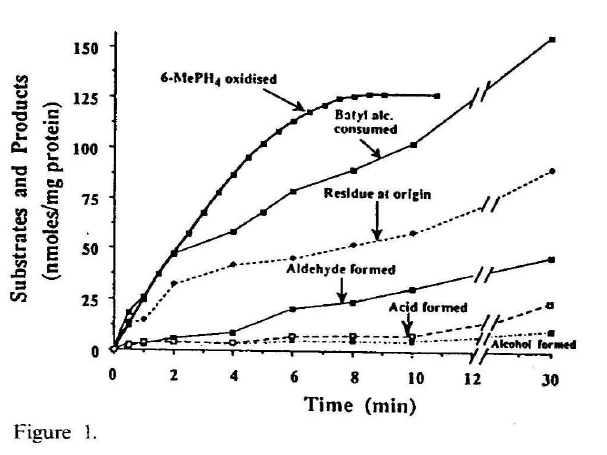
Figure I. the direct assay in Tris-HCl pH 7.5, it would dehyd rate rapidly to the quinonoid species (4). In the pre sent assays the analytical wavelength for studying the rate of change of absorbance was 345 nm, a wavelength at which the 4a-hydroxypterin (5) has no absorbance whatsoever, and the formation of the quinonoid species only was recorded. For the first study of the stoichiometry the experiments were per formed in two parts. In the first part the rate of change of absorbance (at 345 nm) was measured using the direct spectrophotometric assay procedure and the amounts of 6-MePH oxidised at time inter 4 vals were evaluated. In the second part of the exper iment a mixture containing the same ingredients as for the direct spectrophotometric method (see ra diolabel method in MaterialS and Methods): but scal.ed up to 14 ml and using 14C-batyl alcohol, was similarly initiated with 6-MePH4- Aliquots (4X 104 dpm) were removed at intervals of time, quenched, and the products were separated on TLC. Five ra dioactive bands were identified viz: octadecanal, oc tadecanoic acid, octadecanol, unreacted batyl alcohol and a band at the origin (Figure 1). The molar amounts of 6-MeP~ oxidised during the first two minutes were equal to the molar amounts of batyl alcohol consumed. This validates all the measure ments of the kinetic parameters of the monooxygen ase with lipid ether substrates and tetrahydropterin cofactors using the direct assay (8, 9, 18) because all the data were evaluated from initial rate kinetics measured within the first two minutes of reaction. measured by the rate of q-6-MePH 2 (4) produced, then the formation of a 4a-hydroxypterin interme diate (5) is not rate limiting during the first two minutes (see below). Mter the first two minutes the amounts of 6-MePH oxidised become larger than 4 the amounts of batyl alcohol consumed, i.e. the reac tants become uncoupled. This cannot be